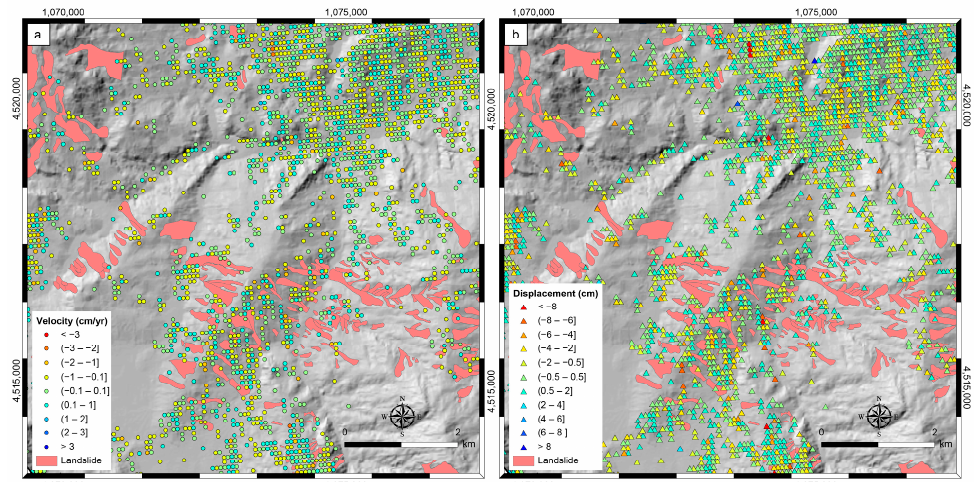
Figure 5. Classifications for ( a ) average velocity of deformation over the five years of observation (2015–2020) and ( b ) cumulative deformation at the last measurement date, adopted in this work.